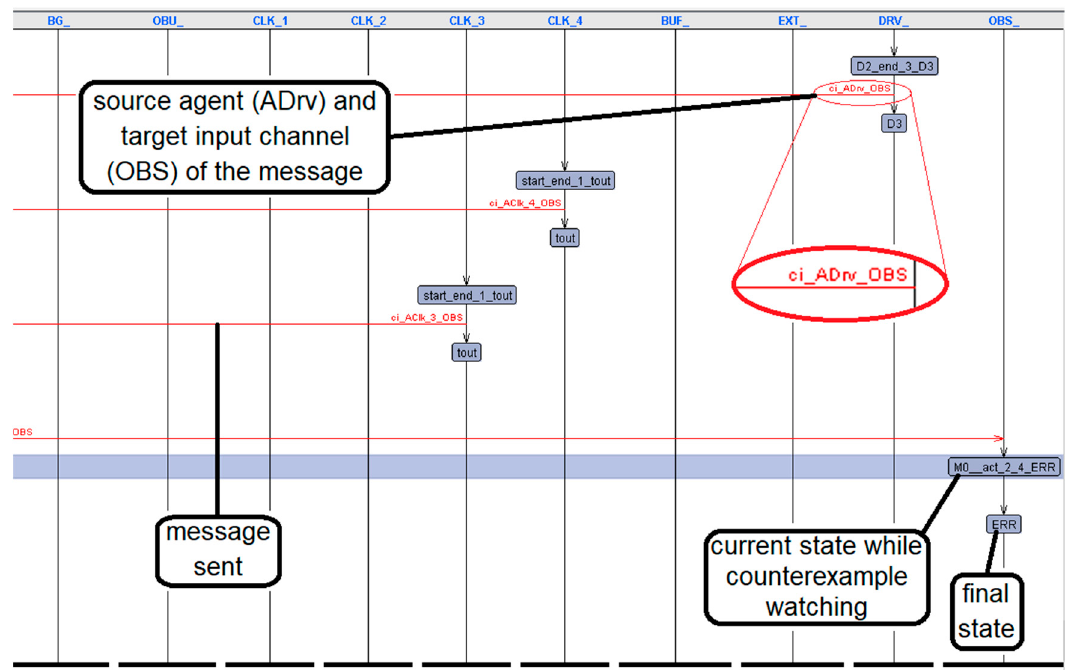
Figure 16. The end part of the counterexample, as shown by the Uppaal veri fi er. The balloons point to speci fi c elements of the counterexample. The message identi fi er is enlarged for readability.